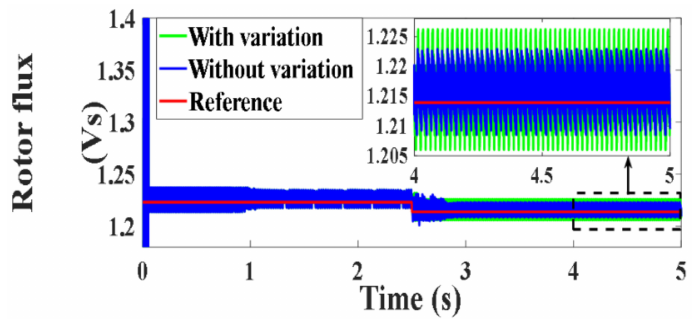
Figure 172. Rotor flux under PVC